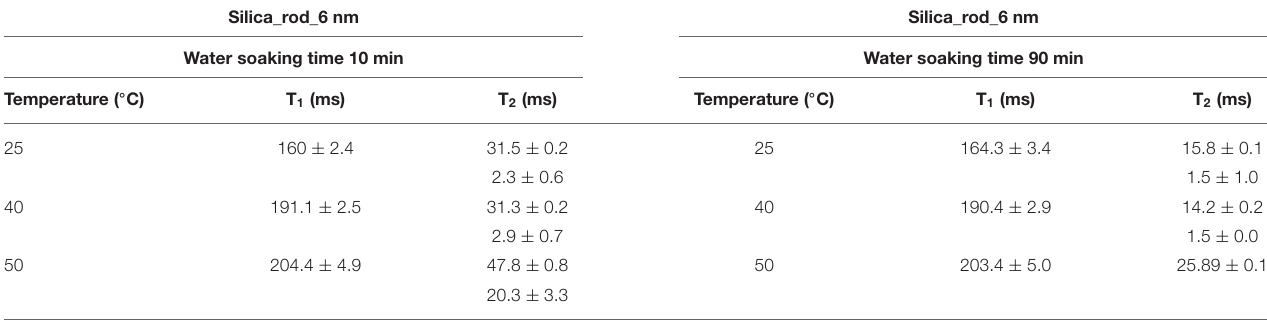
TABLE 6 | T 1 and T 2 values of water confined into nanoporous silica rod.